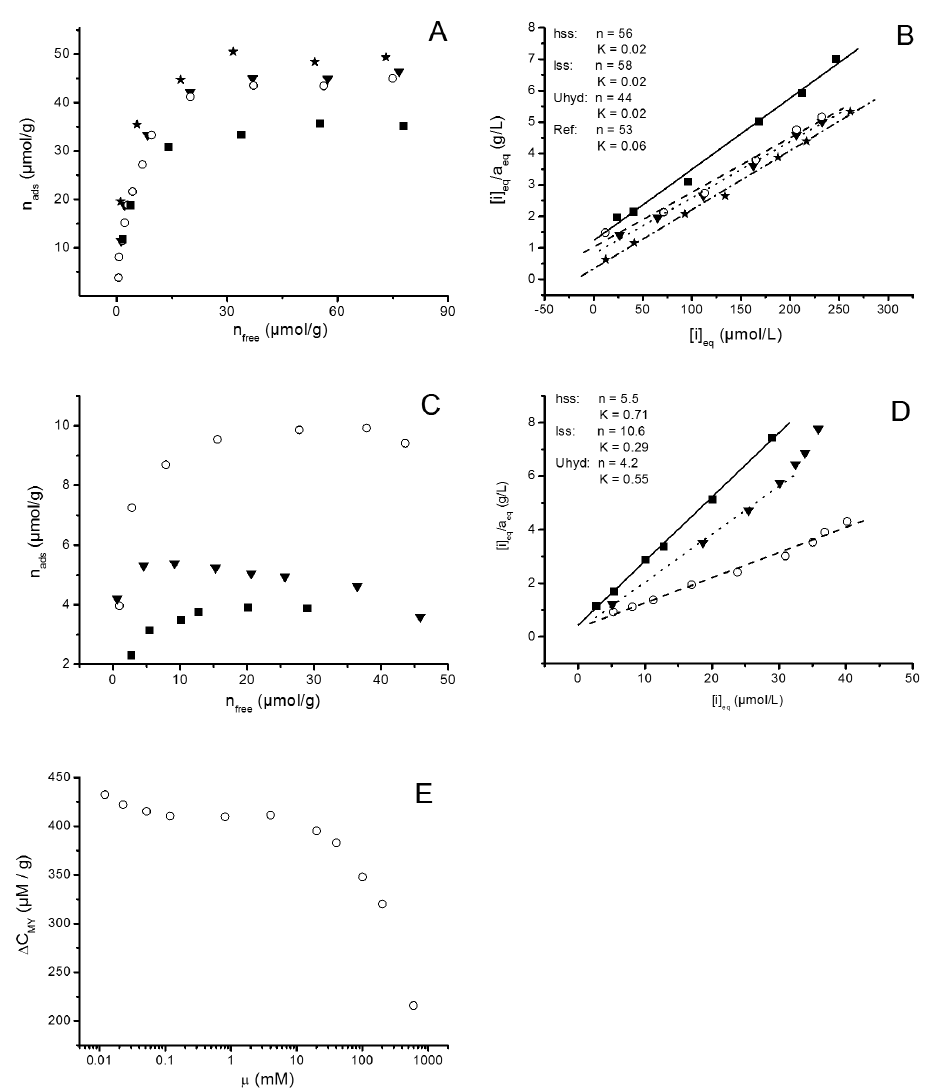
Figure 10. ( A ) Methylene Blue and ( C ) Metanil Yellow adsorption isotherms for fully bleached Kraft pulp reference ( (cid:70) ), and LDH containing pulp samples ( hss ( (cid:72) ), lss ( (cid:13) ), Uhyd ( (cid:4) )); ( B The langmuir fit for methylene blue adsorption) and ( D ) for metanil yellow adsorption are also presented; ( E ) The effect of ionic strength on MY adsorption is shown with lss sample as an